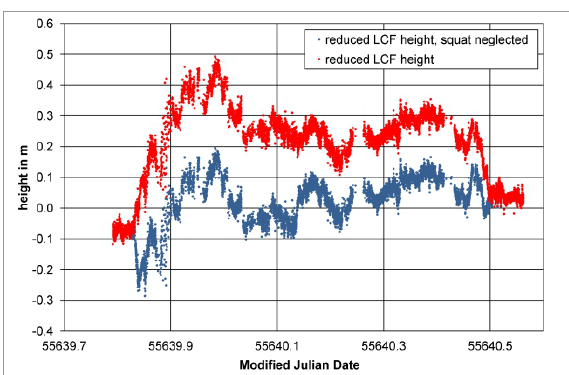
Figure 24. LCF height reduced by geoid heights, tidal variation, ocean loading and Inverse Barometer with and without squat